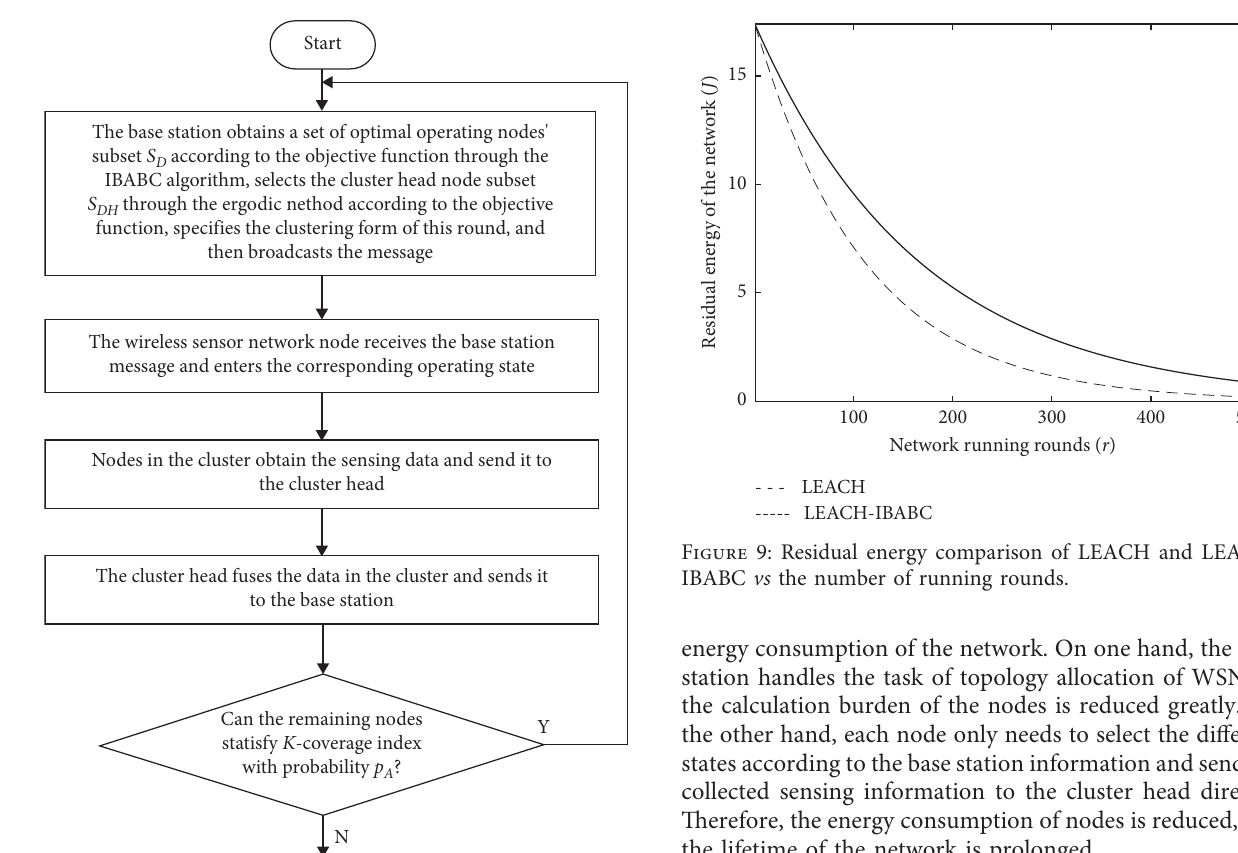
Figure 7: Flow chart of LEACH-IBABC algorithm.